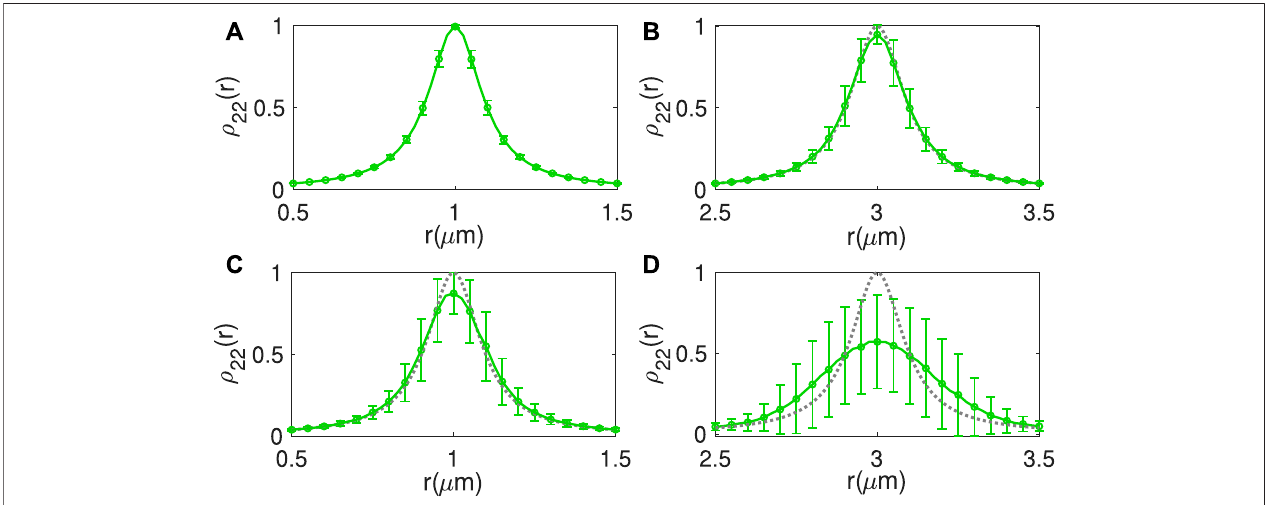
FIGURE4| Radialpopulationdistribution ρ 22 ( r )underdifferentintensitynoises,whicharegivenby (A,B) ξ =1.0%and (C,D) ξ =5.0%atdifferentpositions.Wetake 500 measurements for each point denoted by the error bar and the average result is shown by the green solid line. For comparison the black-dotted line indicates the result without any intensity noise, that is, ξ = 0. Here, Ω c20 /2 π = (30, 90) MHz, respectively for (A,C) and (B,D) , corresponding to the localization positions r loc = (1.0, 3.0) μ m . Other parameters are Ω p 0 /2 π = 3 MHz, Ω c10 /2 π = 150 MHz, and W = 5 μ m.